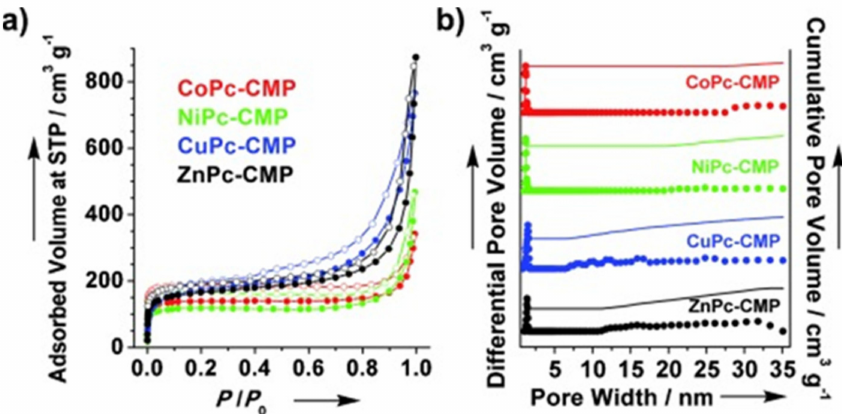
Figure 10. ( a ) Nitrogen sorption isotherms and ( b ) the profiles of the pore size distribution calculated with NLDFT method. Republished with permission of John Wiley & Sons Inc. from [114]; permission conveyed through Copyright Clearance Center